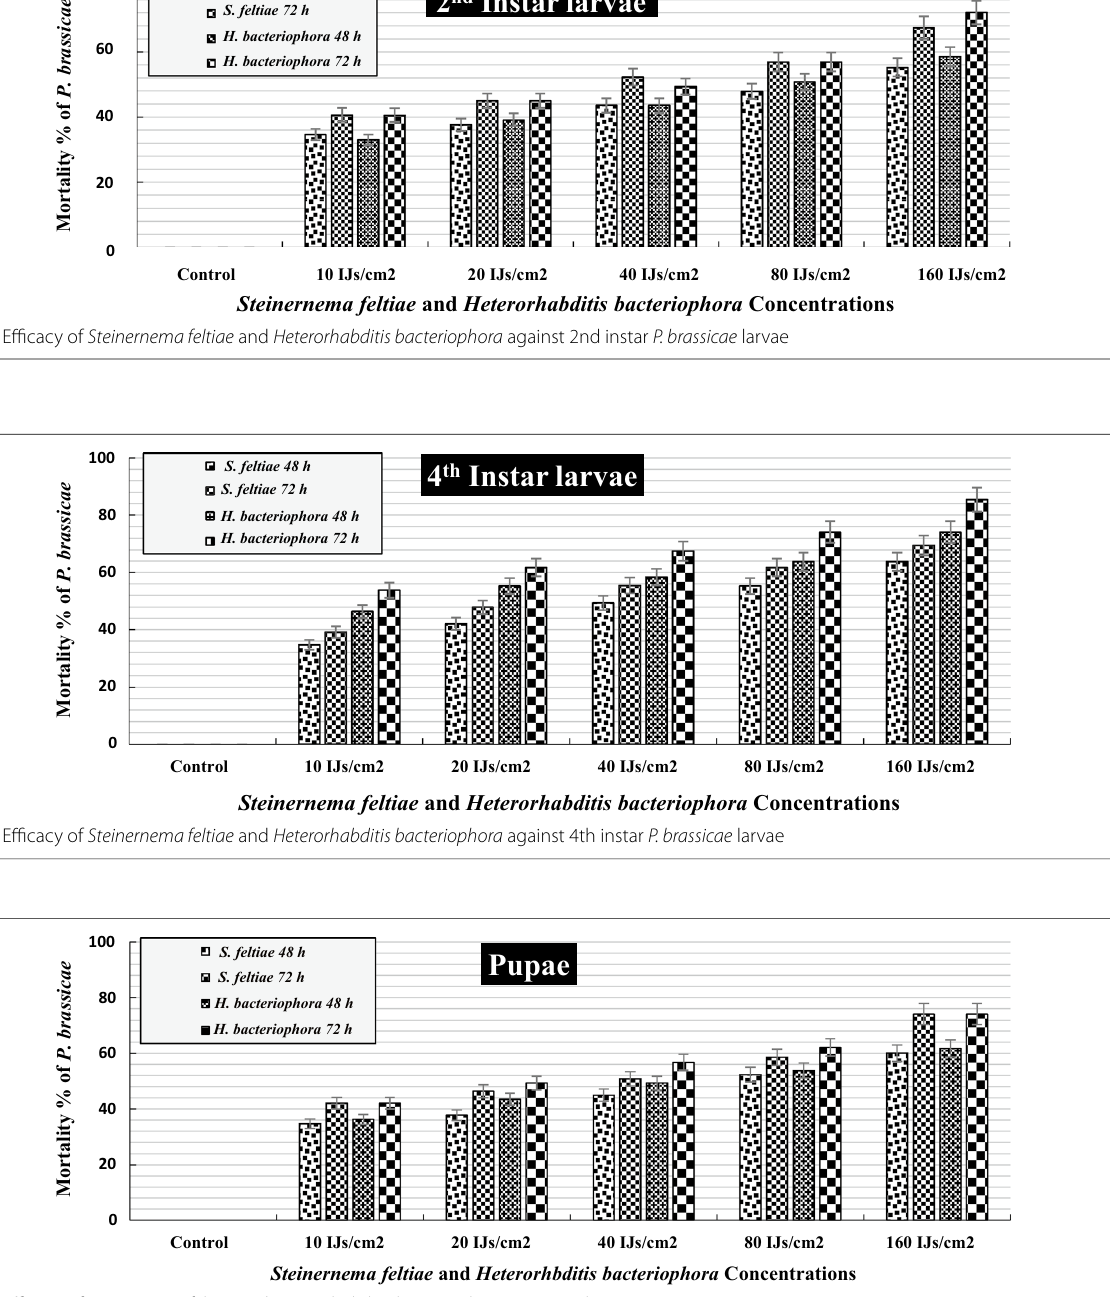
Fig. 3 Efficacy of Steinernema feltiae and Heterorhabditis bacteriophora against P. brassicae